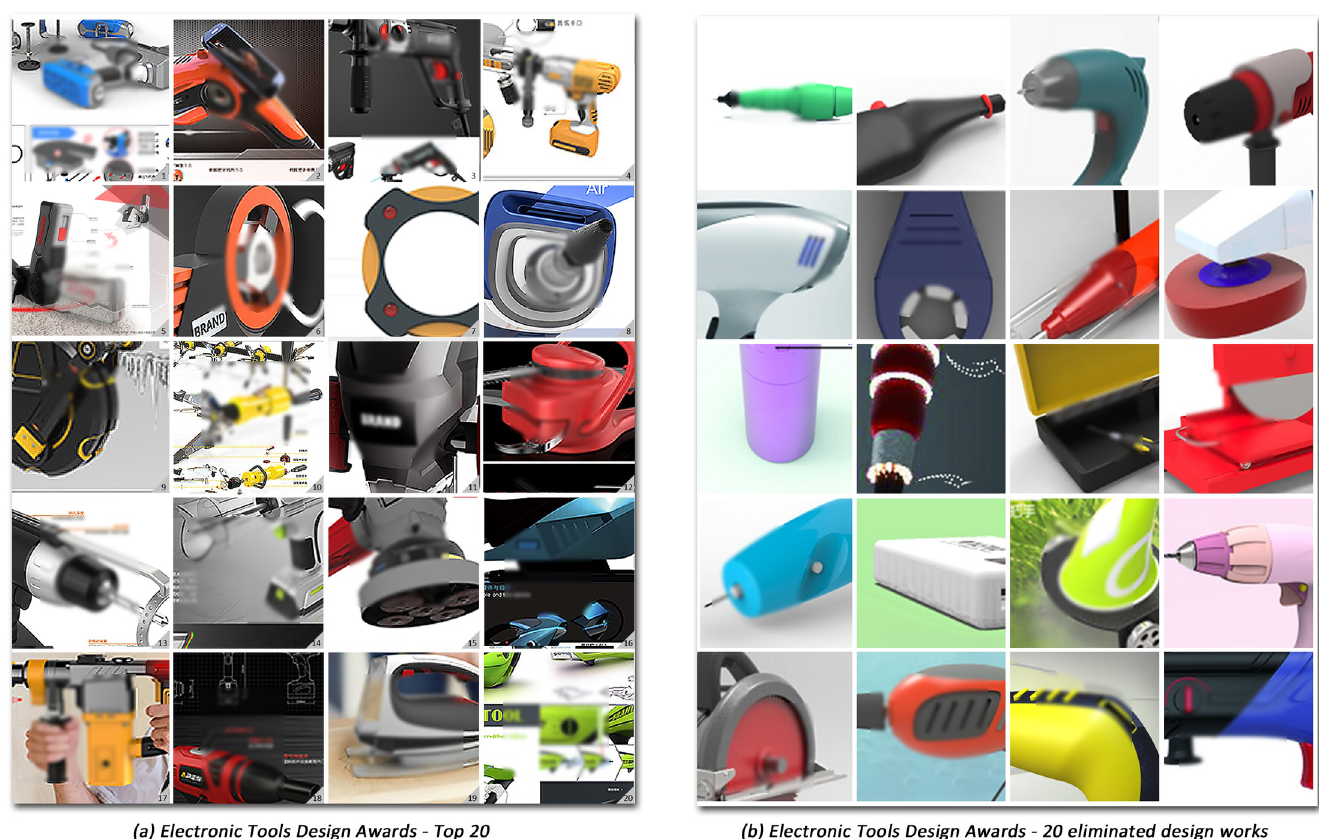
Fig 4. Fig (a) presents layouts of the top 20 design works from the Electronic Tools Design Awards and Fig (b) presents 20 layouts of the eliminated design works in this award as a comparison. Only part of the layout is presented here due to copyright